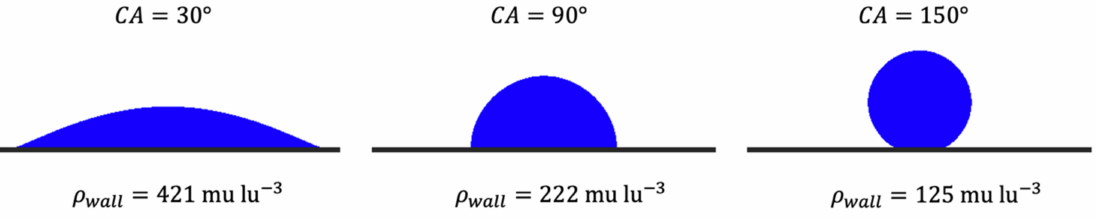
Figure 1. For the calibration of the contact angle the dependence on the pseudo density of the wall ( ρ ) was determined with the help of simulations. Illustrated are the exemplary results for CA 30 ◦ , wall 90 ◦ and 150 ◦ with the liquid (blue) and solid phases (grey).